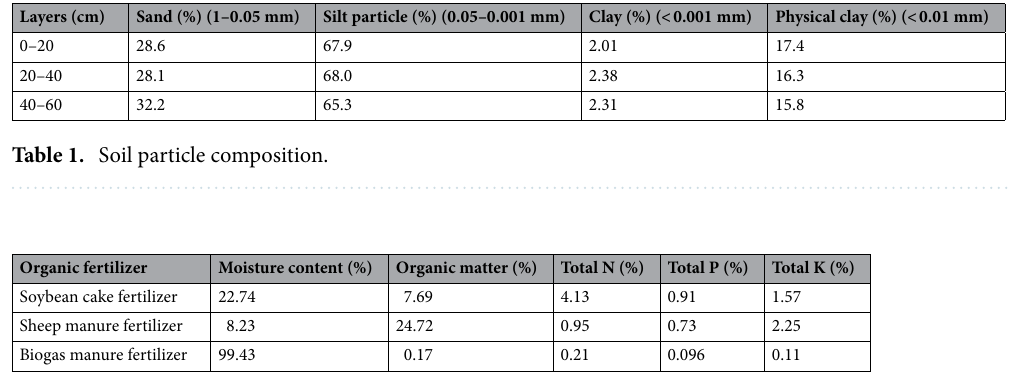
Table 2. Nutrient content of the experimental organic fertilizers.